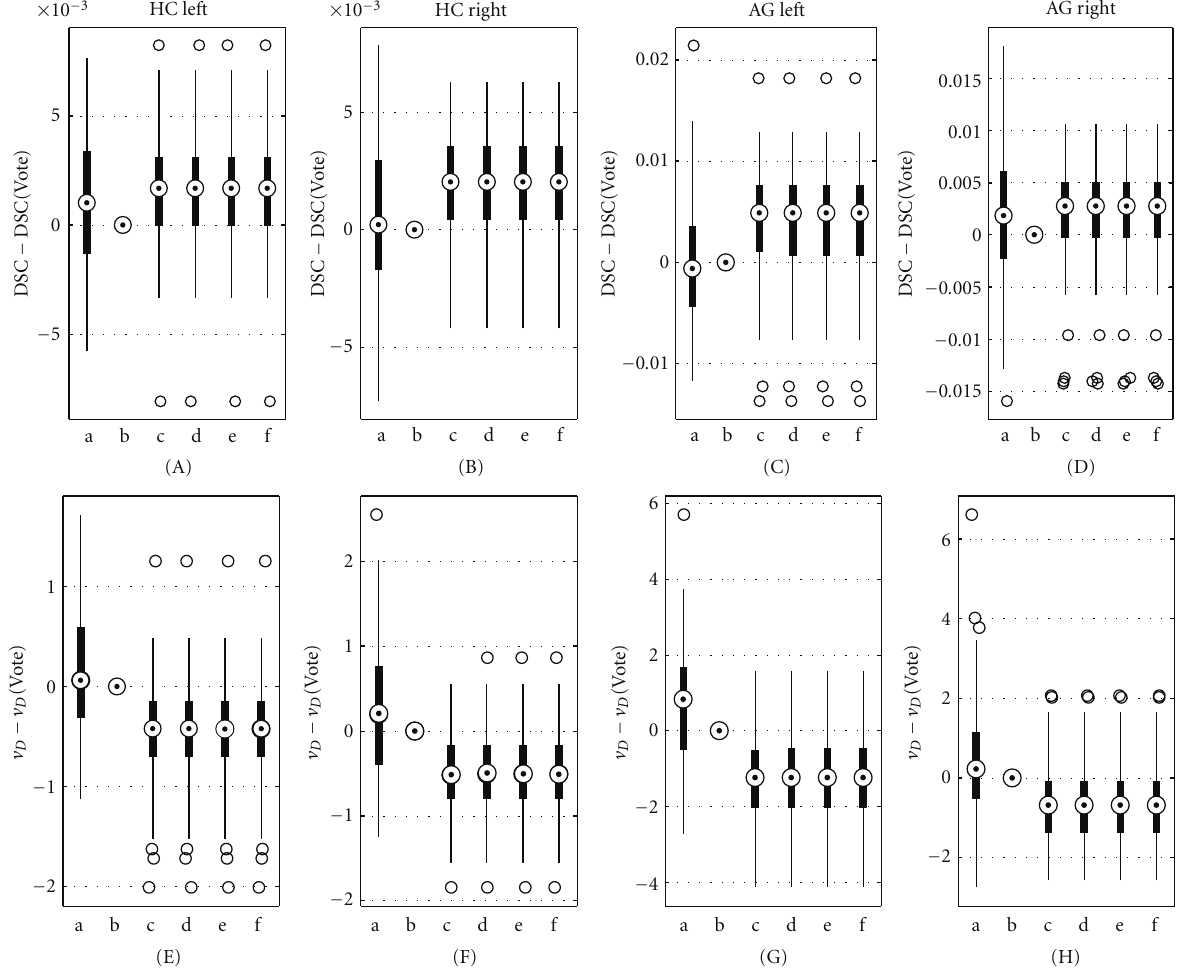
Figure 8: Boxplots of (A)–(D) DSC and (E)–(H) v D , centered on Vote values, for (A, E) HC left, (B, F) HC right, (C, G) AG left, and (D, H) AG right. (a) STAPLE, (b) Vote, (c) SBA, (d) SVS-2D, (e) SVS-3D, and (f) SVS-2D&3D. The centered DSC ( v D ) corresponds to DSC ( v D ) minus DSC ( v D ) evaluated for